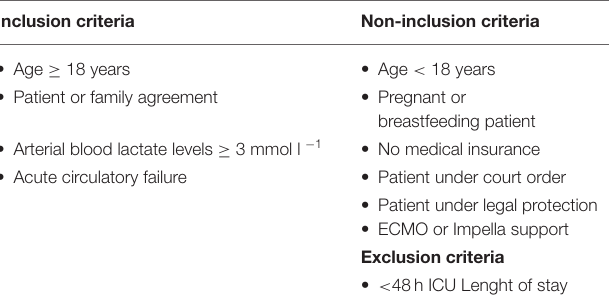
TABLE 2 | Inclusion, non-inclusion, and exclusion criteria of the study. Inclusion criteria Non-inclusion